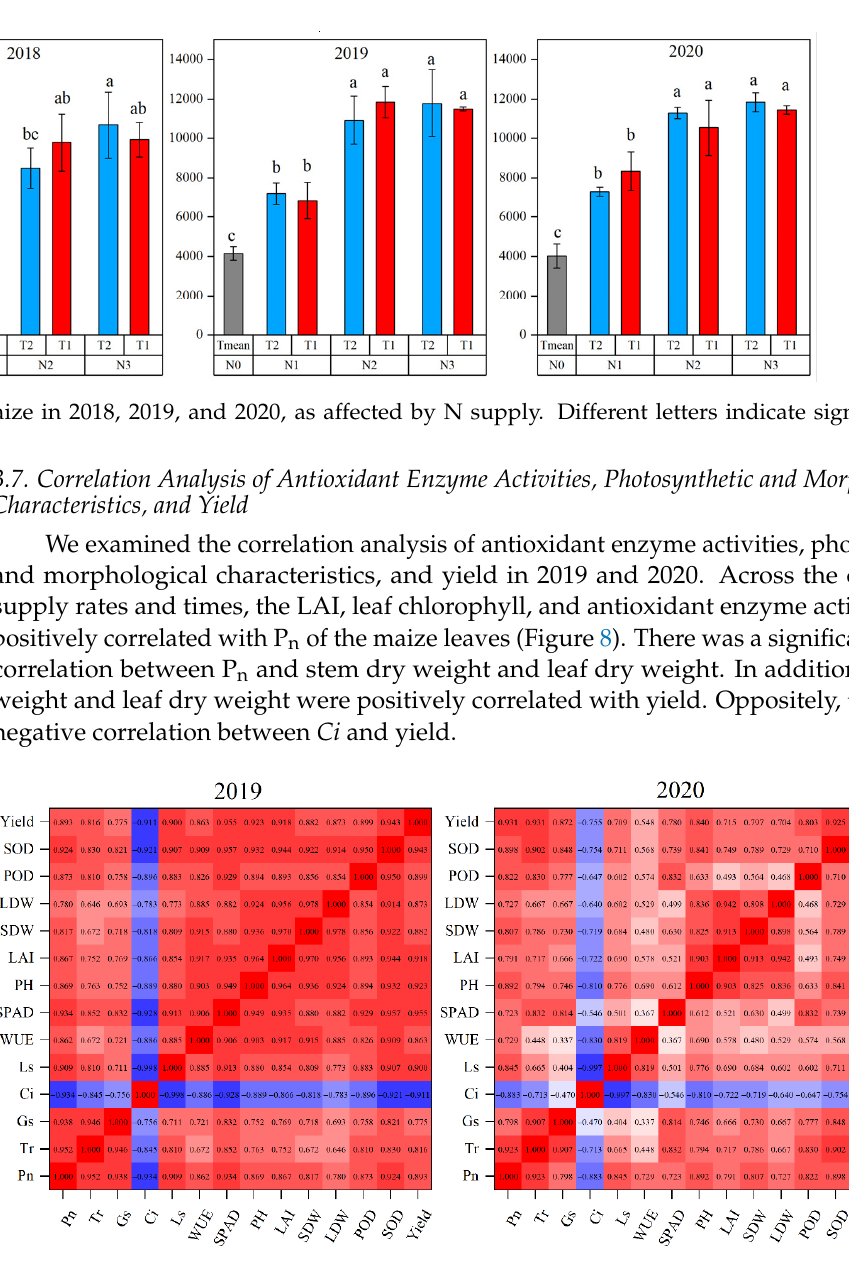
Figure 6. Activity of ( a ) peroxidase (POD) and ( b ) superoxide dismutase (SOD) isozyme in leaves of maize as affected by N supply treatments in 2019. lane 1: N1T2, lane 2: N2T2, lane 3: N3T2, lane 4: N1T1, lane 5: N0, lane 6: N2T1, and lane 7: N3T1. P1–5: different bands of the POD isozyme, and S1–5: different bands of the SOD isozyme.